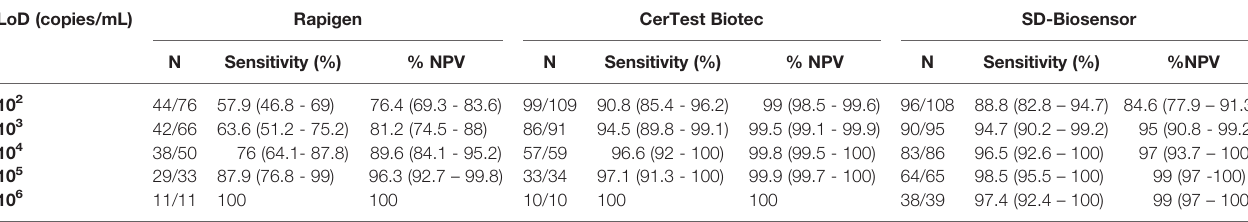
TABLE 3 | Evaluation of the analytical sensitivity of the three different commercial brands of lateral fl ow immunochromatography-based SARS-CoV-2 Rapid Diagnosis Antigen tests (RDAgT) included in this study. LoD (copies/mL)